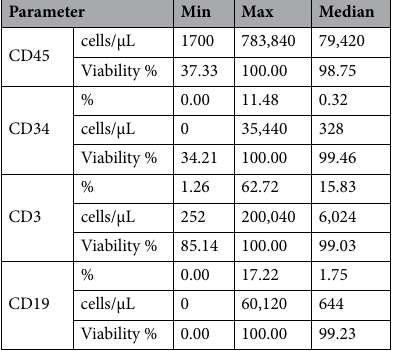
Table 2. Results of the Laboratory range: Several sample types of patients and donors (n = 295) were measured to confirm the laboratory range of frequencies (%), viable absolute values (cells/µL) and viability (%) for the parameter CD45, CD34, CD3 and